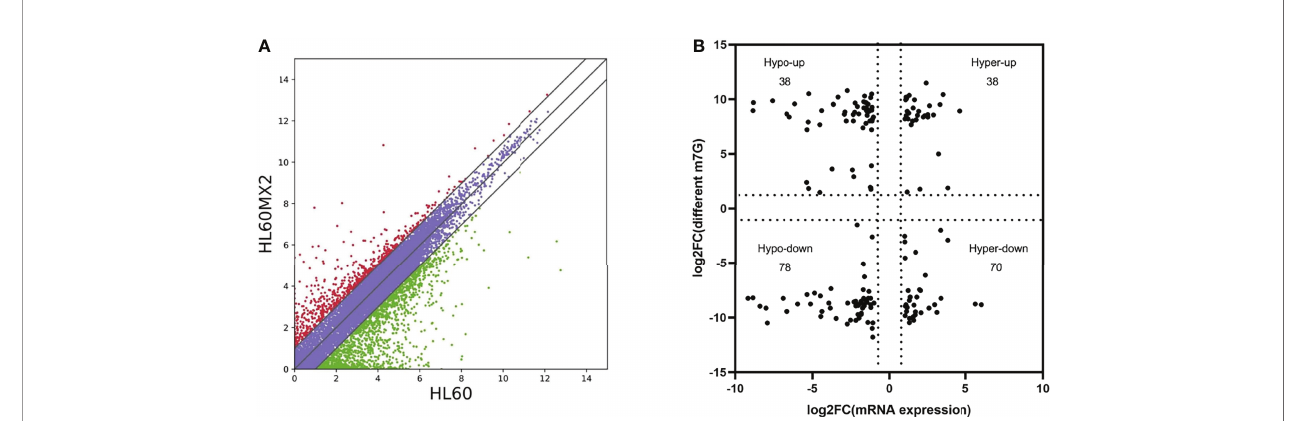
FIGURE 3 | Joint analysis of m7G methylation and transcriptome. (A) Scatter plots of the differentially expressed mRNAs between HL60 and HL60/MX2 cells. (B) Conjoint analysis of m7G methylation and the transcriptome of